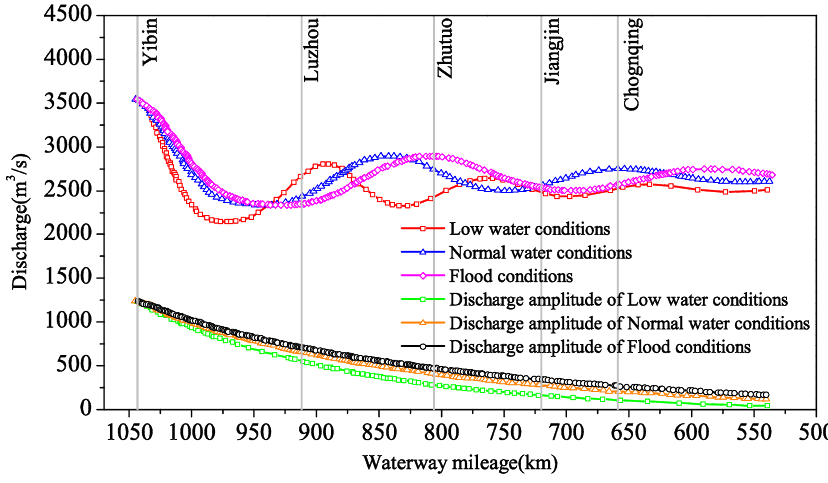
Fig. 16 Changes in the flow along the Yibin-Fuling reach at a certain time for the three working